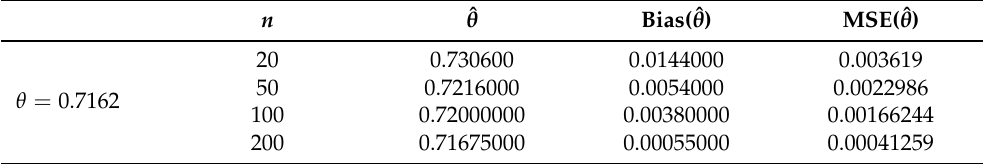
Table 3. Estimation for θ corresponding to strong dependence. n ˆ θ Bias(ˆ θ ) MSE(ˆ θ )